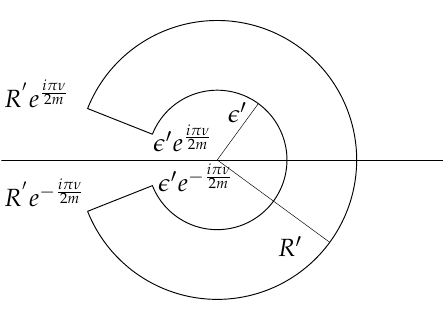
Figure 3. Representation of the contour C (cid:48) , with R (cid:48) = R ν 2 m and (cid:101) (cid:48) = (cid:101) ν 2 m